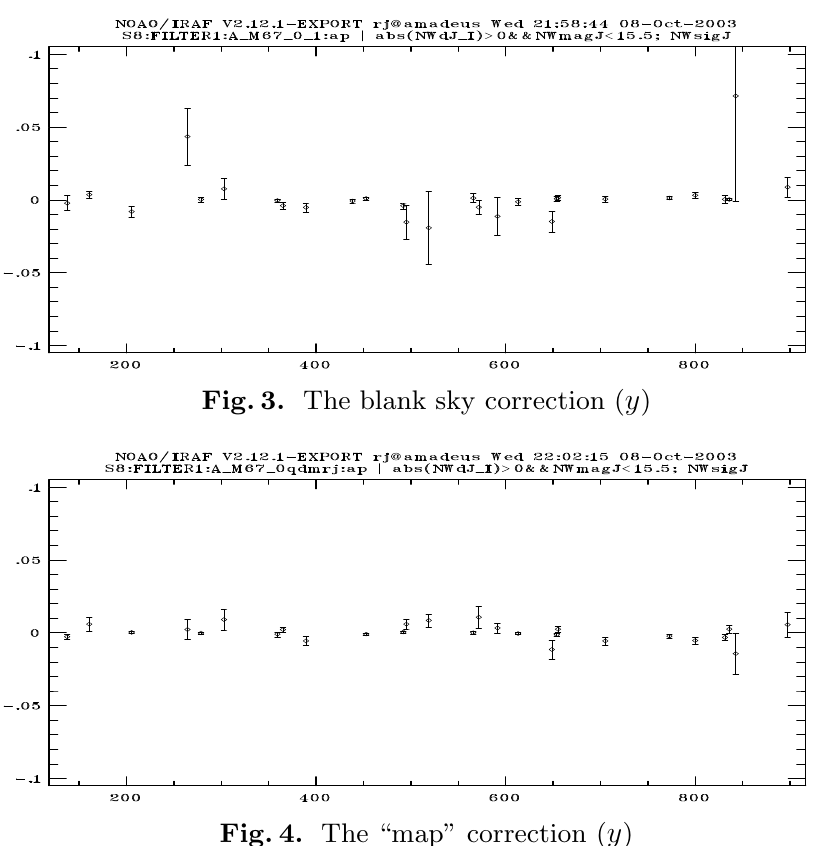
Fig. 4. The “map” correction ( y